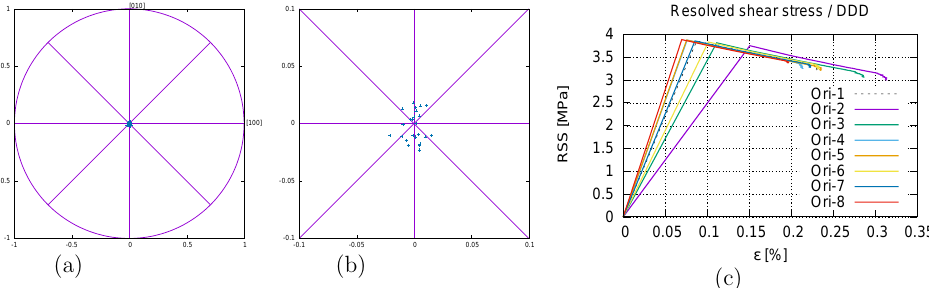
Fig. 16: Eight DDD simulations: (a) the initial eight orientations projected to the loading axis (24 poles according to the symmetry); (b) zoom-in view for (a); (c) RSS-strain curves showing the inhomogeneous CRSS values (without multiplying the Taylor factor) and the variation of local Young’s moduli.